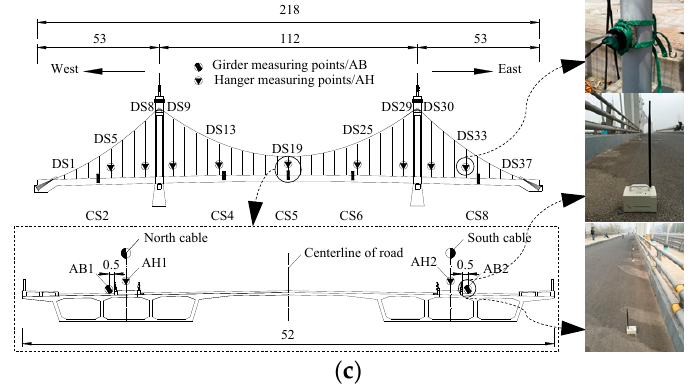
Figure 4. Layout of the structural health monitoring (SHM) system: ( a ) Deformation; ( b ) Internal force; and ( c ) Vibration characteristic (Unit: m).